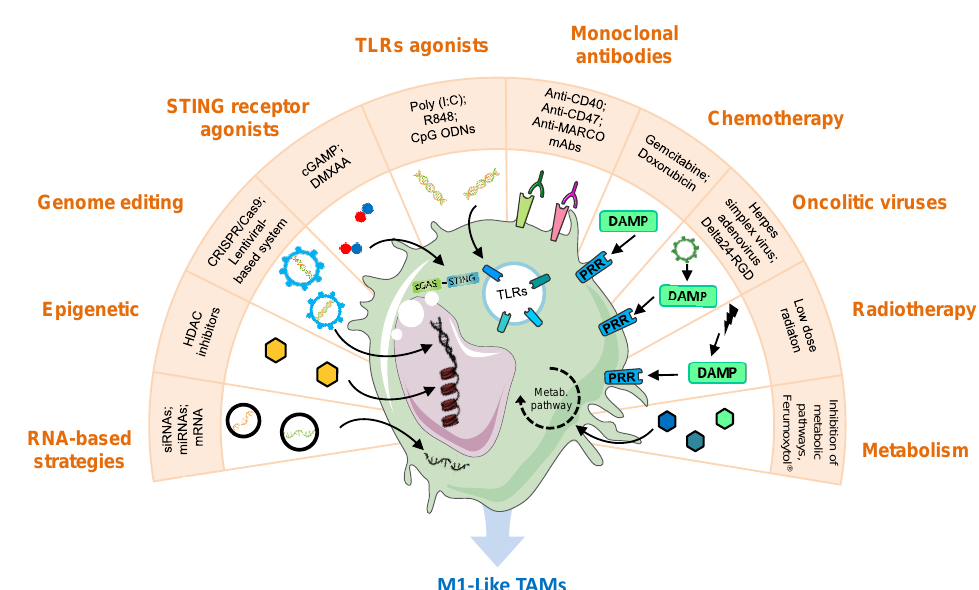
Figure 2. Reprogramming of tumor-associated macrophages is a promising target for novel anti-tumor treatments. This figure summarizes and gives examples of various strategies with this purpose. The inhibition of immunosuppressive genes has been investigated through the delivery of the CRISPR / Cas9 machinery or lentiviral vectors to directly edit TAMs genome, HDAC inhibitors for epigenetic regulation or nanoparticles encapsulating siRNAs, miRNAs, or mRNAs to manipulate gene transcription. TLR and STING agonists have been shown to reprogram TAMs towards an M1-like phenotype. Monoclonal antibodies targeting the CD47 / SIRP α axis, activating CD40, or blocking the scavenger receptor MARCO activate the antitumoral functions of macrophages. Traditional chemotherapeutics such as gemcitabine or doxorubicin, oncolytic viruses, and low doses of radiation, which induce the release of DAMPs by tumor cells, have been reported to polarize macrophages towards M1-like phenotype, through pattern recognition receptor stimulation. Manipulation of TAMs metabolism has been modestly explored, showing good results in experimental settings through the inhibition of glycolysis, hypoxia, lactate, cholesterol, IDO, arginase, glutamine, or adenosine pathways in macrophages, but also by the administration of iron-based nanoparticles (NPs) (Ferumoxytol ® ) or oxygen. cGAMP, cyclic guanosine monophosphate–adenosine monophosphate; CpG ODNs, CpG oligodeoxynucleotides; DAMP, damage-associated molecular pattern; DMXAA, 5,6-dimethylxanthenone-4-acetic acid; HDAC, histone deacetylase; MARCO, macrophage